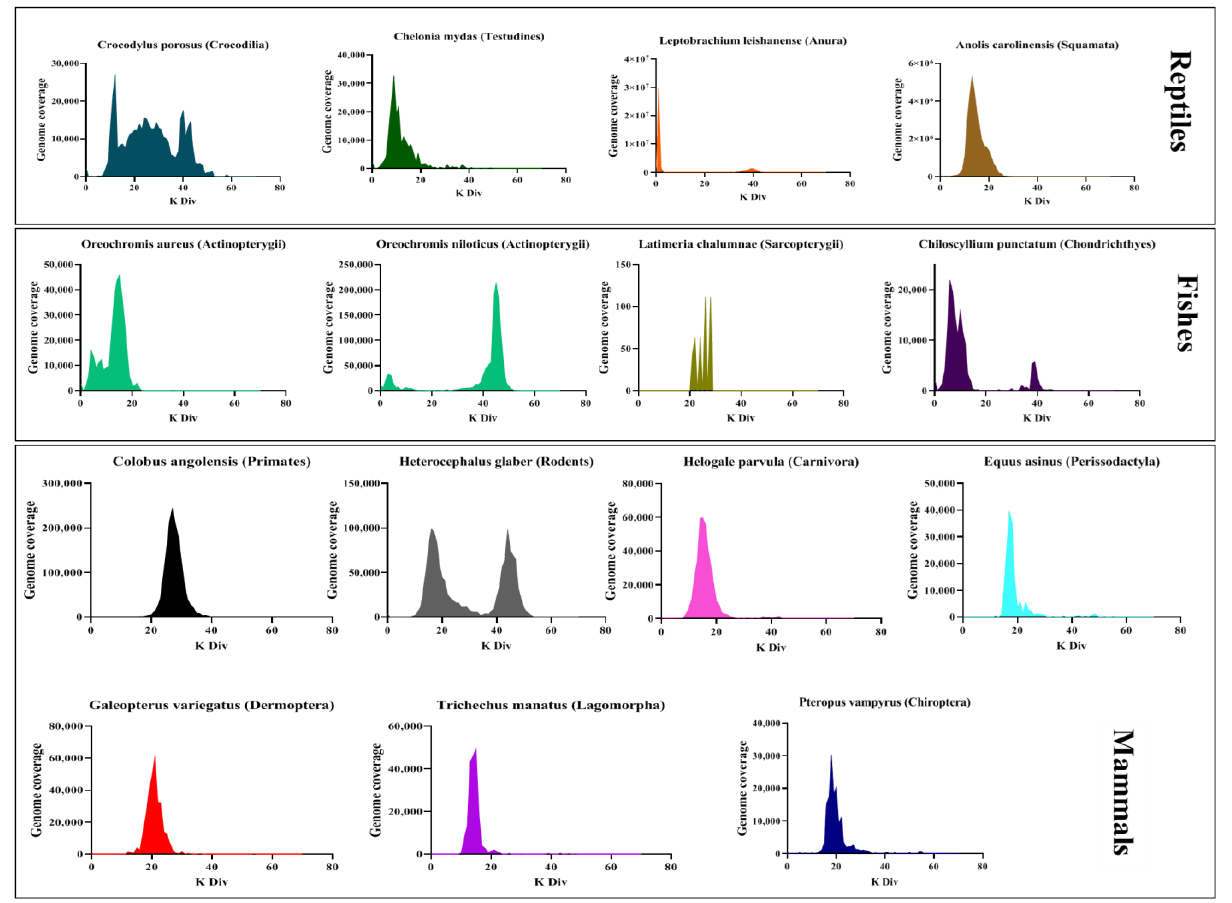
Figure 5. Evolutionary dynamics of Tigger in animals. RepeatMasker utility scripts were used to calculate the Kimura divergence from consensus sequences or the representative sequence (Tarailo- Graovac and Chen 2009). The y -axis represents the coverage (kb) of each Tigger element in the genome and the x -axis indicates the Kimura divergence estimate. Each color in the three orders (Mammal, Reptile, and Fish) represents species from different classes of the animal kingdom.